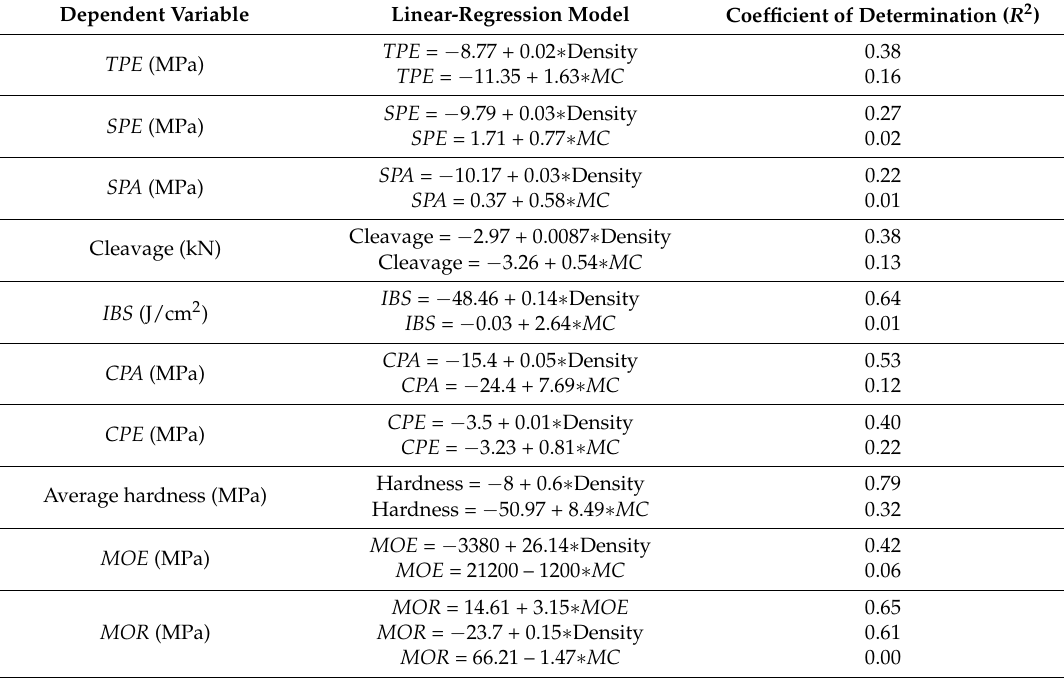
Table 5. The correlations between density, MC and mechanical properties.